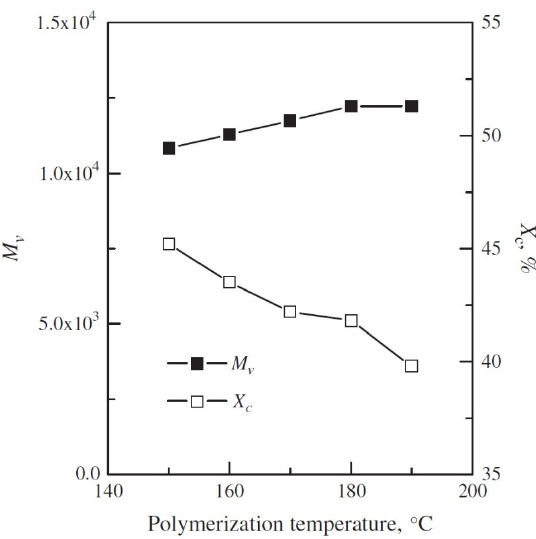
Figure 15. Effects of polymerization temperature on the viscosity average molecular weight and degree of crystallinity of the matrix resin of GF/APA-6 composites. Reprinted from Reference [86], under open-access license.